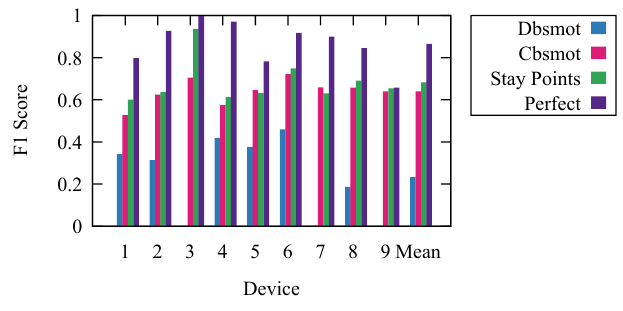
Figure 3. Comparing